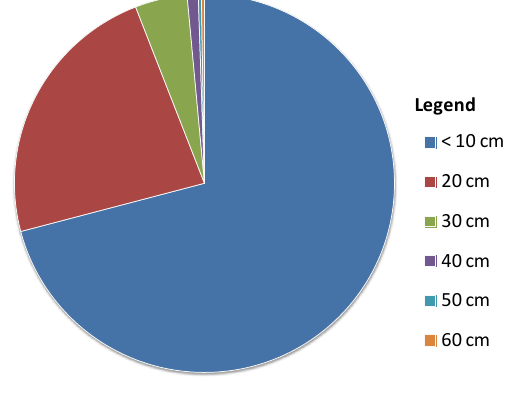
Figure 7. Vegetation height adjacent to the